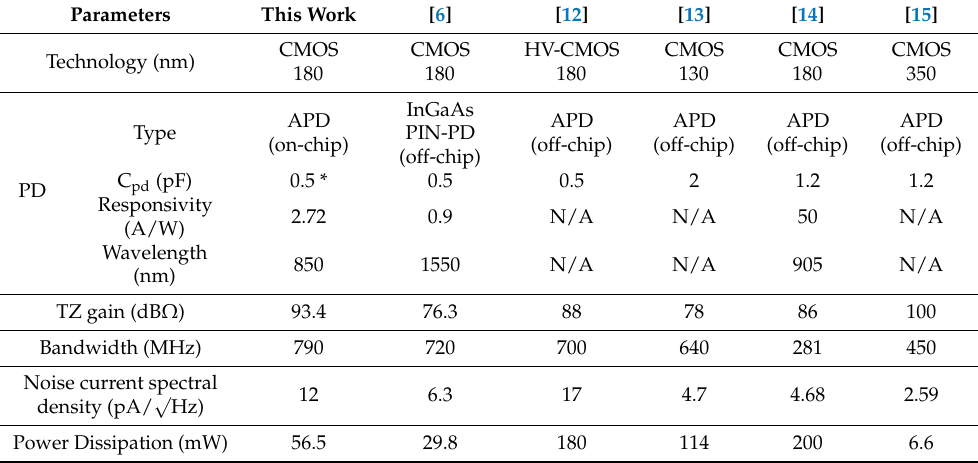
Table 1. Performance summary and comparison of the proposed optoelectronic Rx IC with other prior arts.